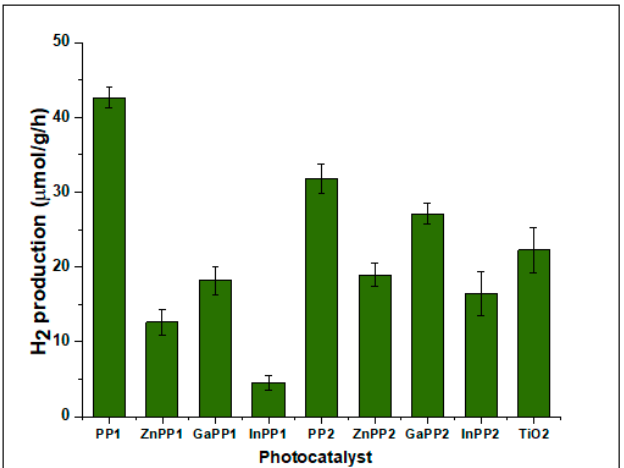
Figure 6. Hydrogen generation rates for the P -TiO 2 photocatalysts in 1% methanol solution under simulated solar